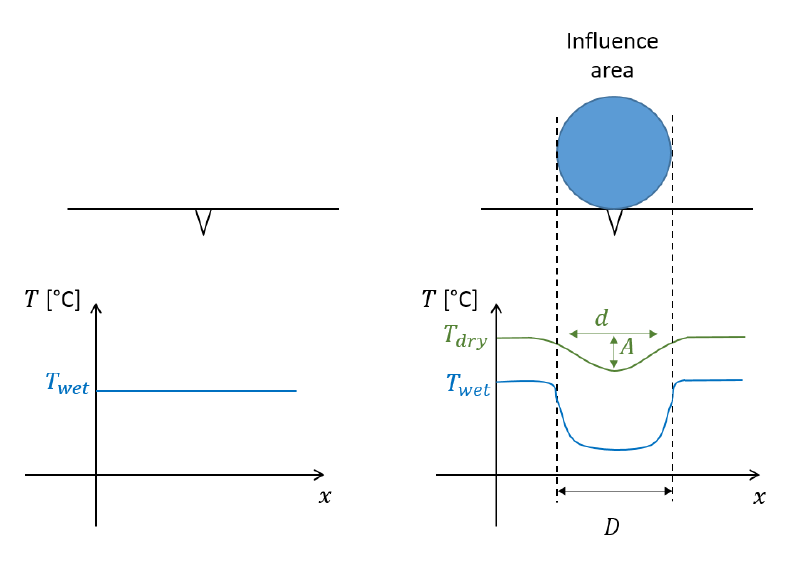
Figure 19. Influence area during a bubble growth on a nucleation site. This area can be characterized by the size d and the amplitude of the thermal disturbance A for the dry side of the